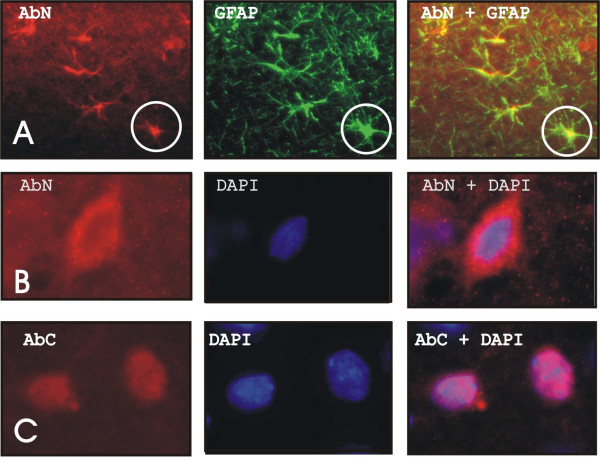
Expression of ZAS3 in astrocytes and neurons in the brain cortex. (A) Images of sections of brain cortex stained with AbN (left) and GFAP antibodies (middle). The images were superimposed in the right. Most AbN-IR cells were also stained by GFAP antibodies. Whereas AbN stained the cell bodies and the cylindrical processes, GFAP also stained the more elongated branching processes. An example of a cell stained with both AbN and GFAP antibodies is shown in a circle. (B) and (C) are high magnification of neurons stained with AbN, and AbC, respectively and DAPI. While AbC stained the nucleus, AbN yielded intense cytoplasmic staining.